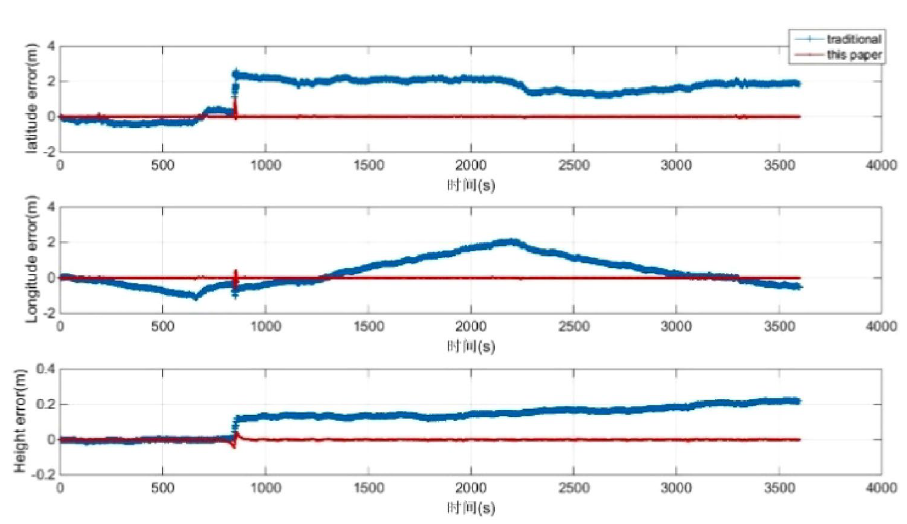
Figure 8. Position error comparison.